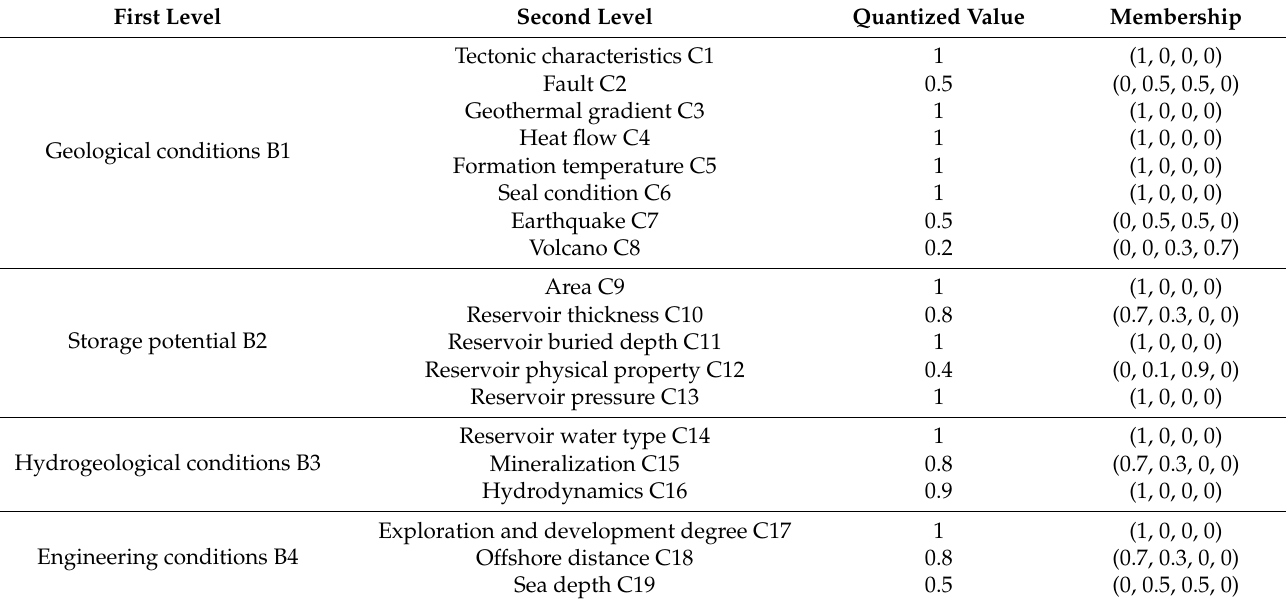
Table A6. Evaluation results of each